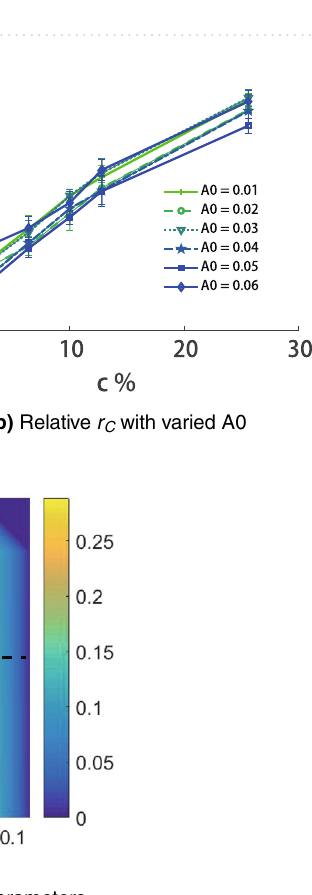
Figure 4. Simulated confidence. The reported confidence ( rc ) by confidence neuron is consistent with the reported confidence in human experiments. Error bars show the standard error for 10 sessions. ( a ). The correct ratio as an increasing function of confidence. ( b ). The confidence increases with the strength of evidence for the trials whose reports are correct but decreases with the strength of evidence for trials whose reports are incorrect. ( c ). The ratio of correct report of the trials with higher confidence is higher than that with lower confidence given the same evidence.